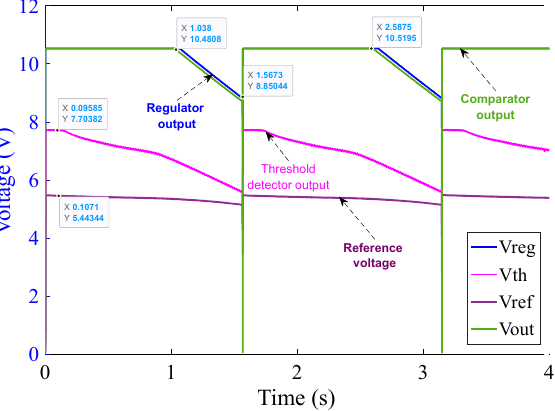
Figure 20. 1 Ω burden circuit operation at 100 A(rms) input current over 20 ms.